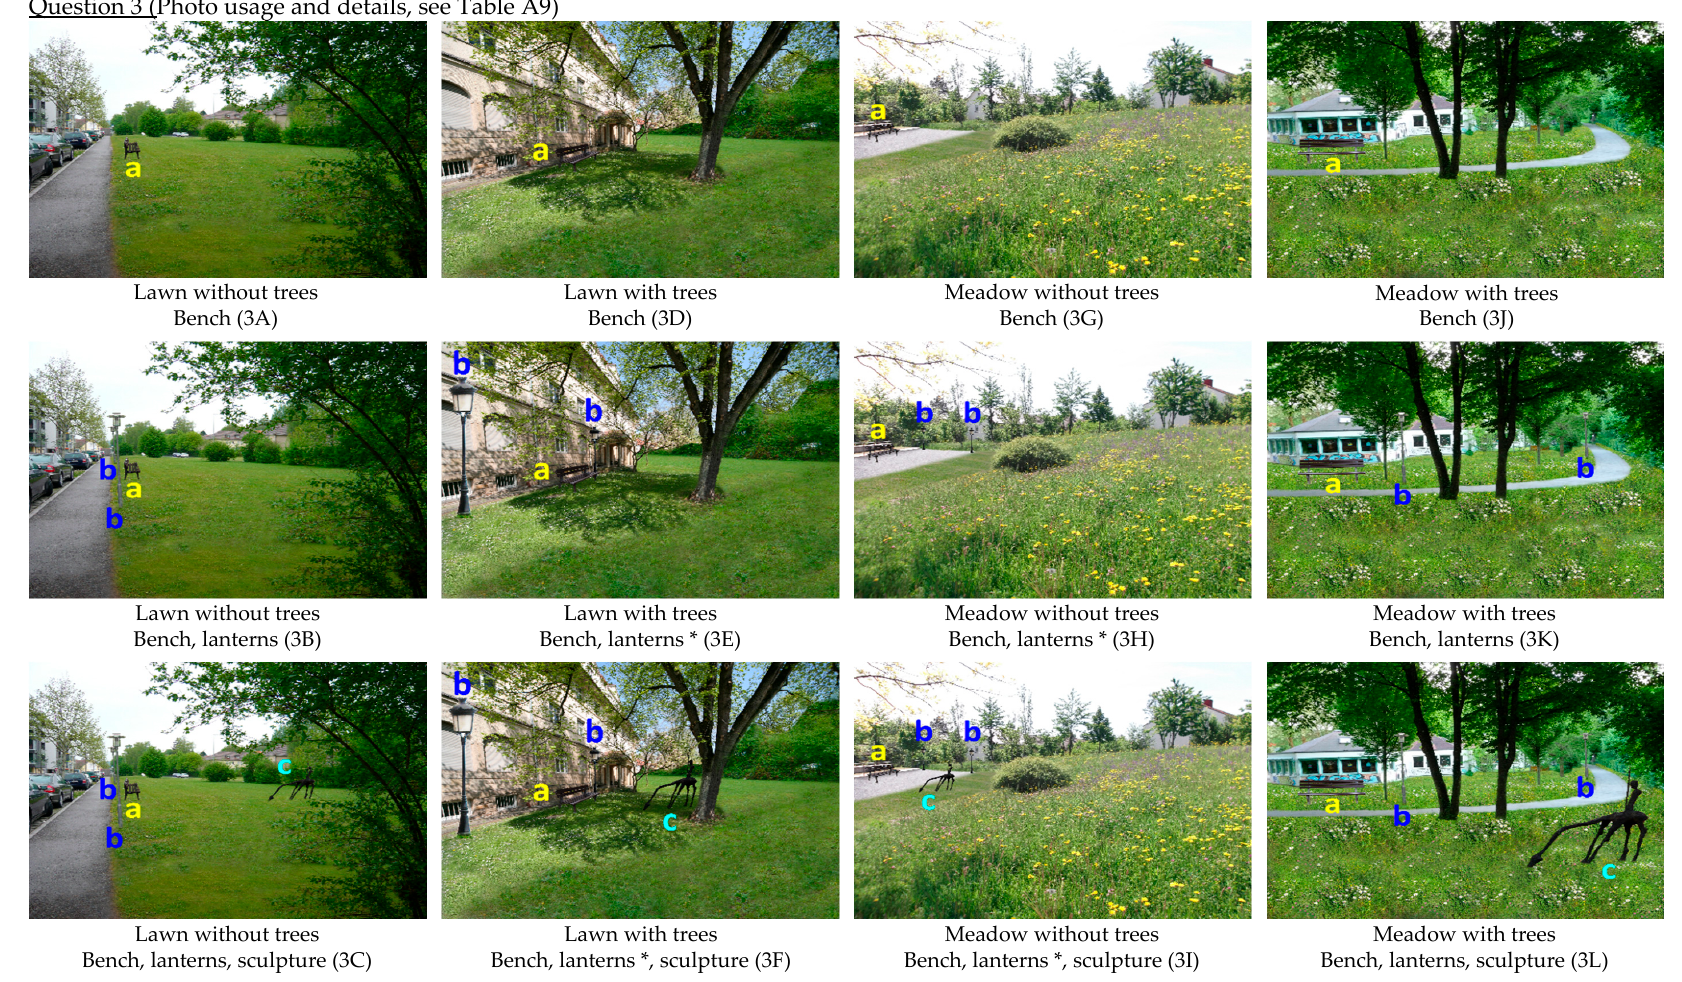
Figure 5. The aim of Question 3 was to establish possible preferences for a meadow or a lawn and the possible influence on the respective preference caused by the presence of structural elements. For further explanations, see text. (*) FreeImages.com / sue anna joe (Artist’s Member Name) [105].